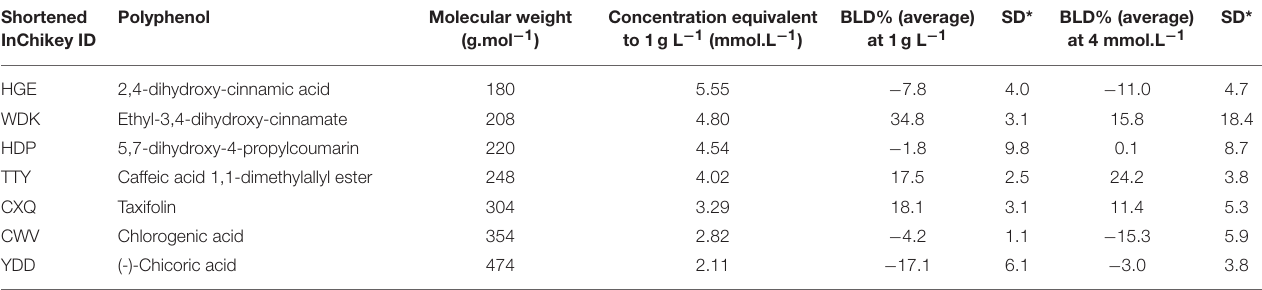
TABLE 2 | Comparison of the antibacterial properties of 7 polyphenols determined at 1g L − 1 and 4 mmol.L − 1 against E. coli ATCC25922. Shortened InChikey ID